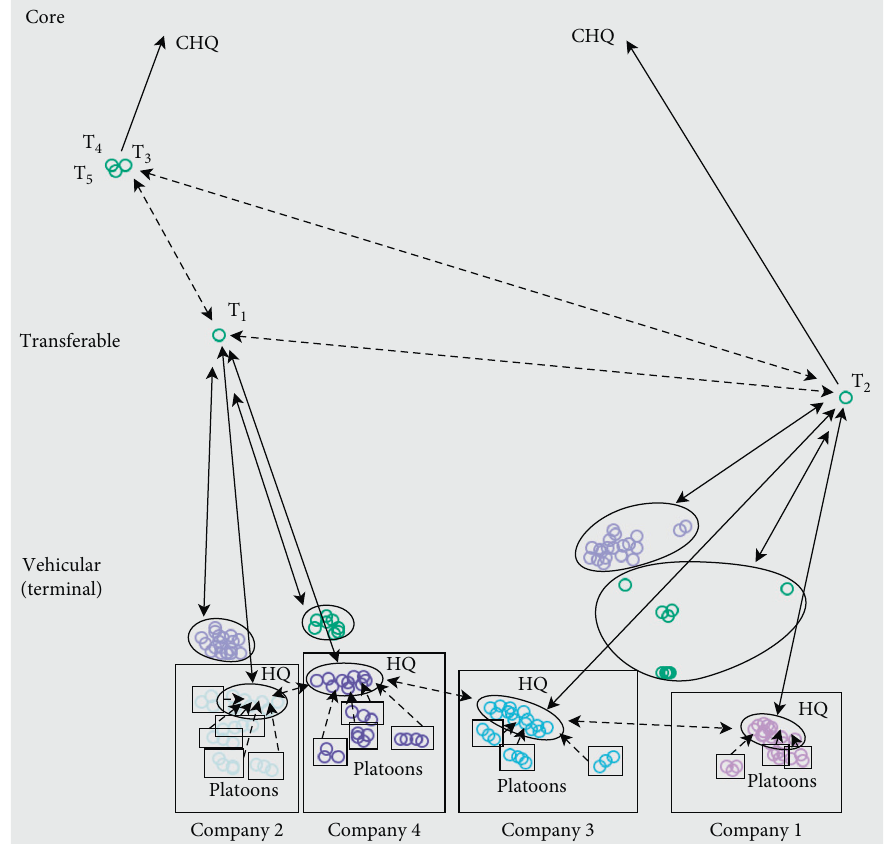
Figure 9: Network management traffic through the hierarchical organization of the Anglova scenario at moment t � 7780s. The solid lines show the traffic upwards and downwards in the hierarchy and the dashed line the horizontal data exchange within the